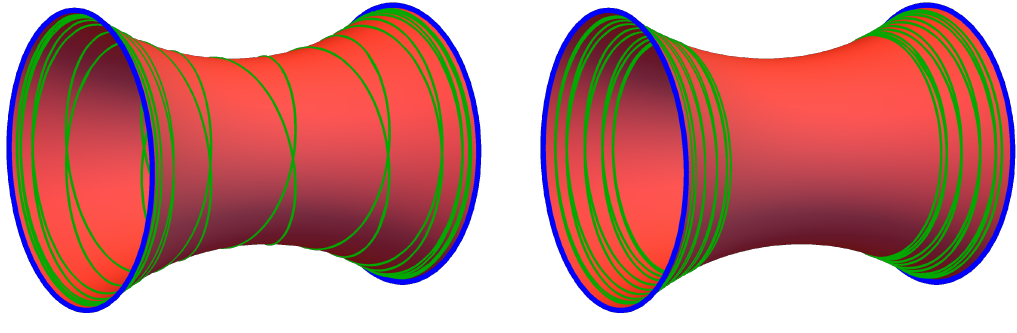
Figure 2 . The wormholes with perturbative string excitations on top of them. These pictures are cartoons, since the actual model that we will consider is three-dimensional and instead of the green worldline curves, we will have worldsheets wrapping the geometry. It turns out that the model realizes only the possibility in the right picture: there are no perturbative string excitations that connect the two asymptotic regions, but only separate string excitations that stay close to the two